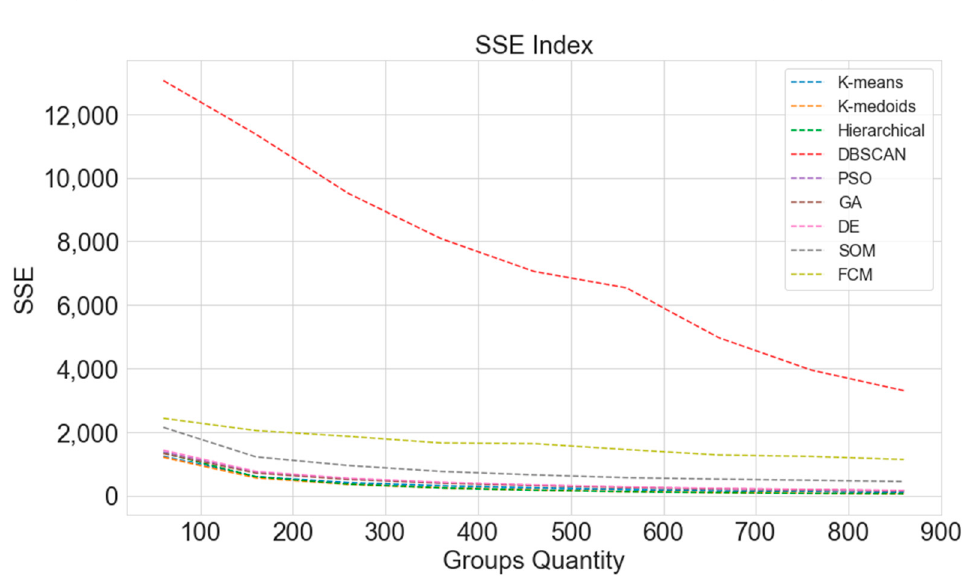
Figure 6. SSE index evaluation over a different number of groups considering nine clustering